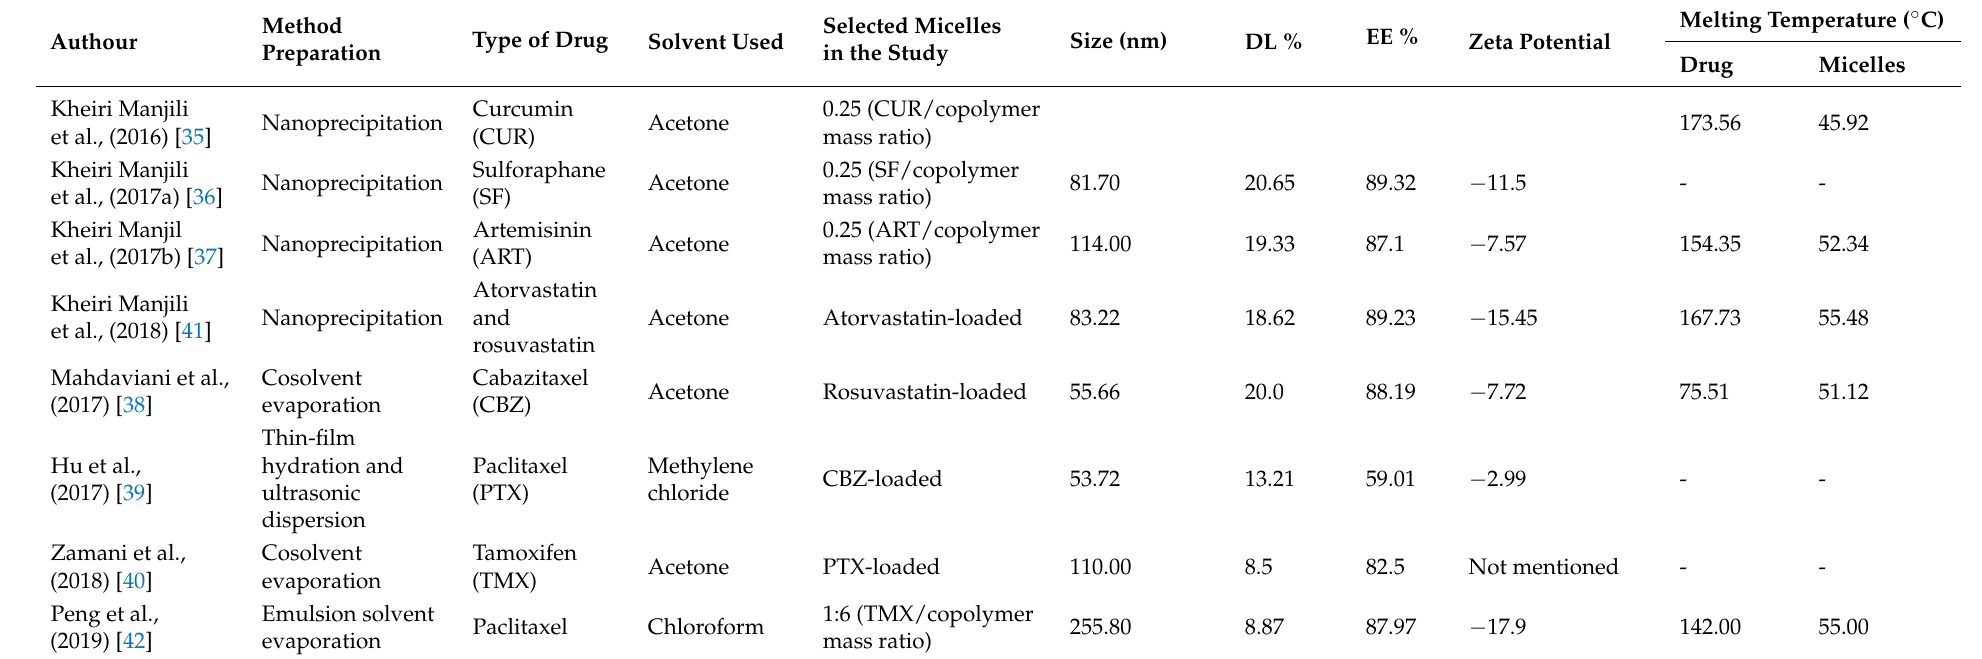
Table 5. Summary of the preparation and characterisation of